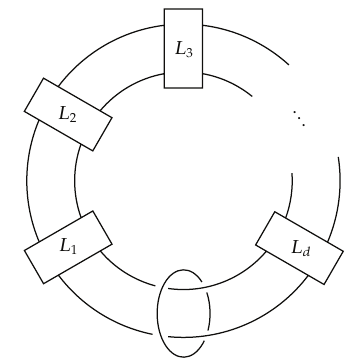
Figure 1: The oriented links L (cid:3) m,d (cid:4) in S 3